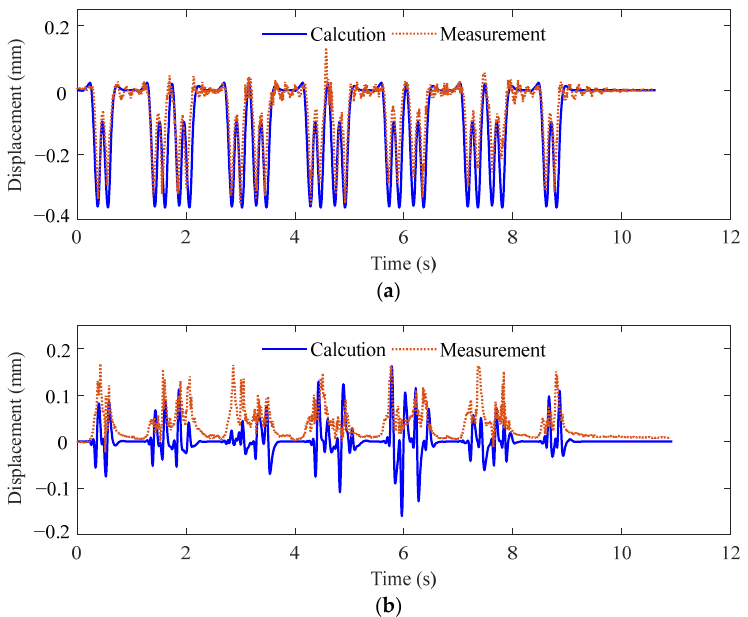
Figure 4. Comparative results of the displacement for the track: ( a ) vertical direction and ( b ) lateral direction.